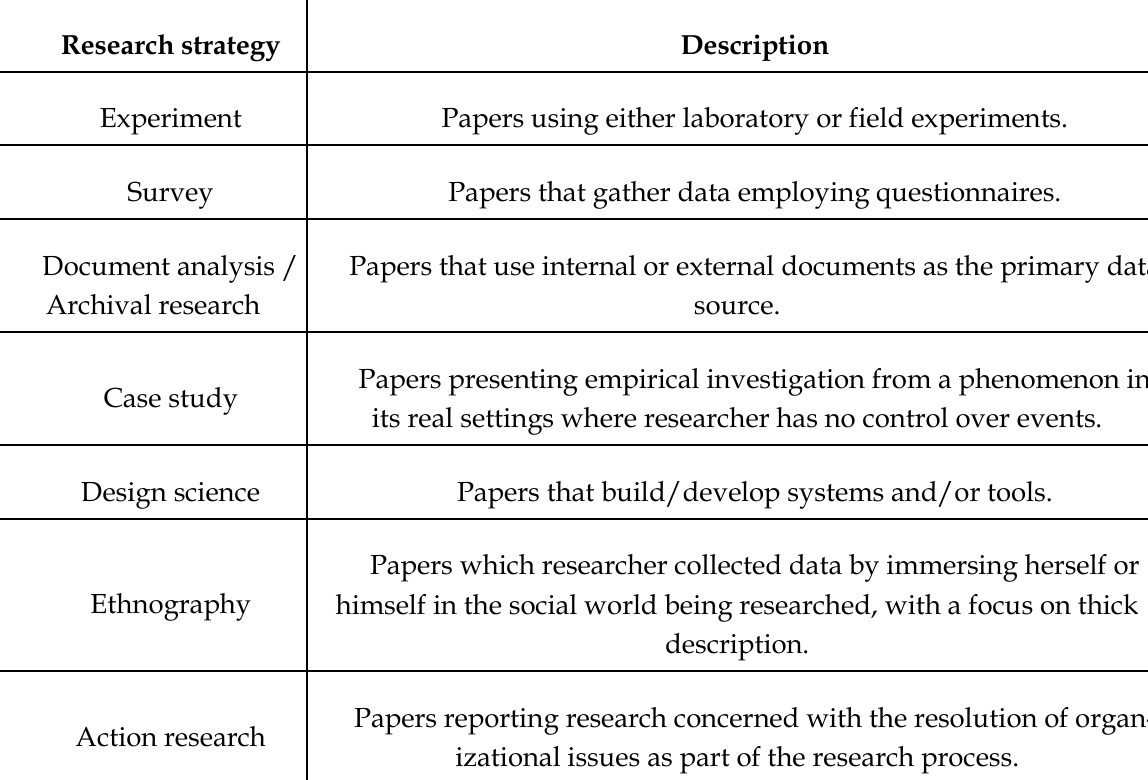
Table 4: Classification of research strategy Research